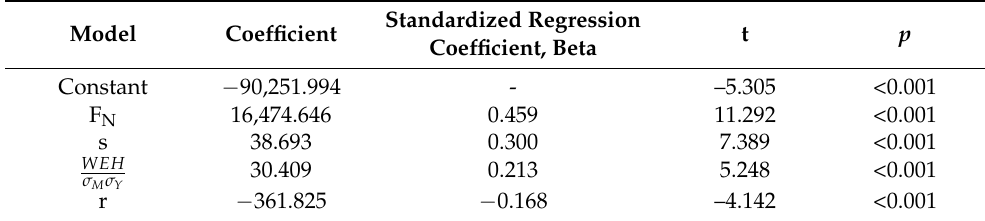
Table 8. Coefficients of the regression model for groove volume in single-asperity scratch test.